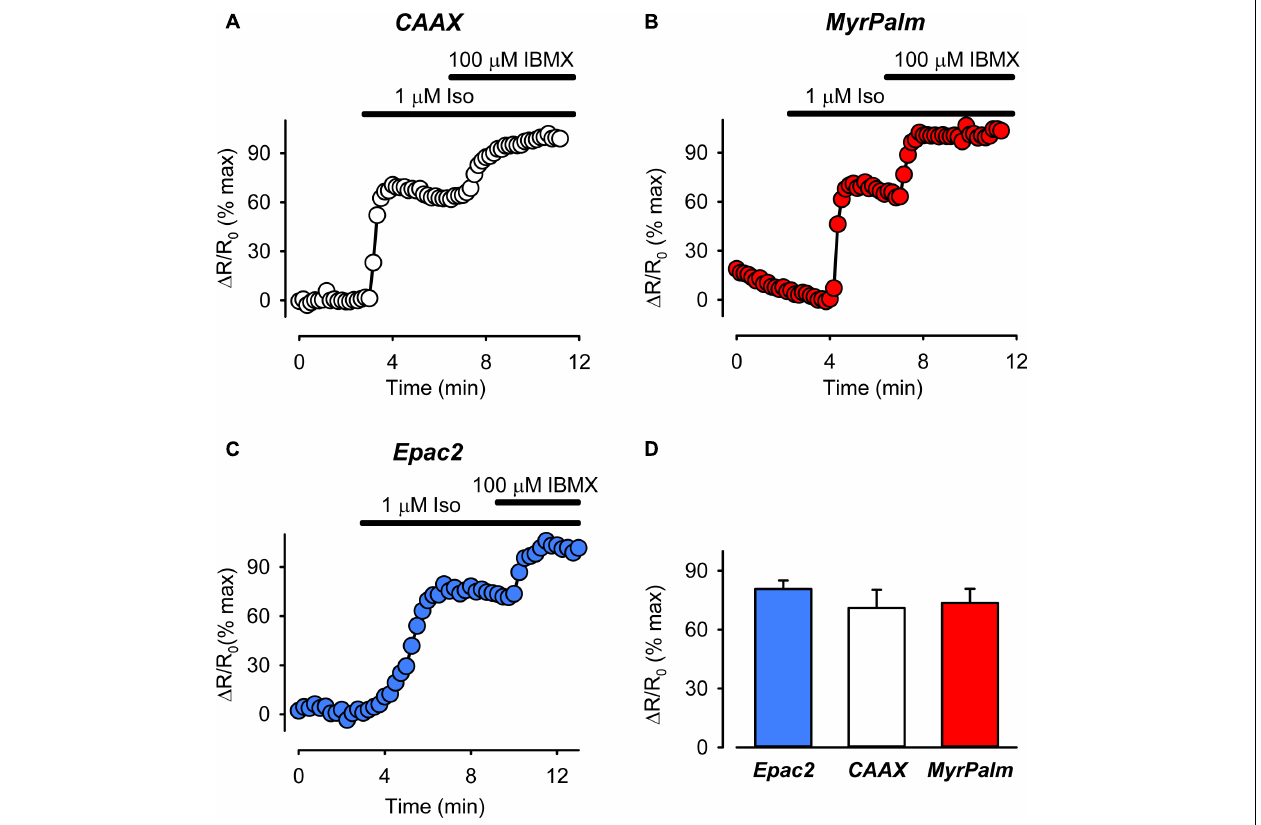
FIGURE 3 | The magnitude of cAMP responses detected by biosensors targeted to different subcellular locations are similar following treatment with the β AR agonist isoproterenol (Iso). (A–C) Representative time course of changes in the normalized FRET response ( (cid:49) R/R 0 ) in cells expressing Epac2-CAAX (CAAX, white circles), Epac2-MyrPalm (MyrPalm, red circles), and Epac2-camps (Epac2, blue circles), under control conditions, and following exposure to 1 µ M Iso, and 1 µ M Iso plus 100 µ M IBMX. (D) Summary of average FRET responses to 1 µ M Iso in cells expressing Epac2-camps (n/N = 8/6, blue bar), Epac2-CAAX (n/N = 10/5, white bar), and Epac2-MyrPalm (n/N = 14/5, red bar). Responses to 1 µ M Iso were not significantly different between the probes (one-way